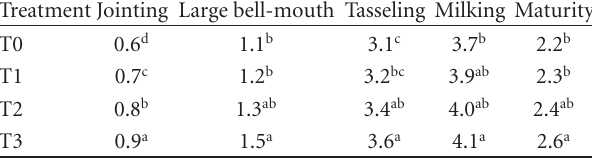
Table 5: E ff ect of irrigation during the winter wheat growing season on the RUE of summer maize at di ff erent growth stages